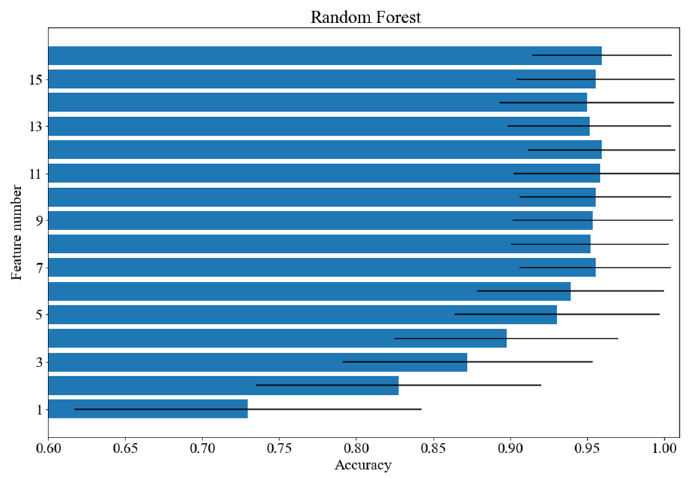
Figure 3. Accuracy scores for various number of features: random forest.